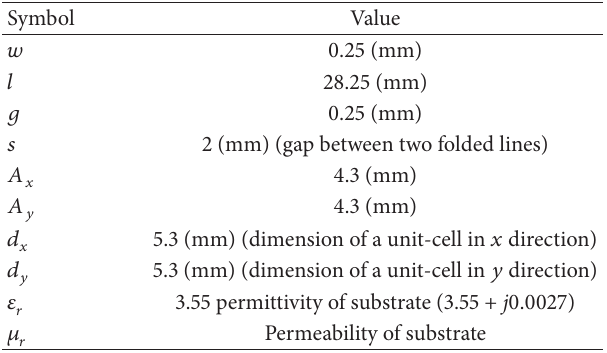
Table 2: Parameters of new FL-LHM in Figures 1 and